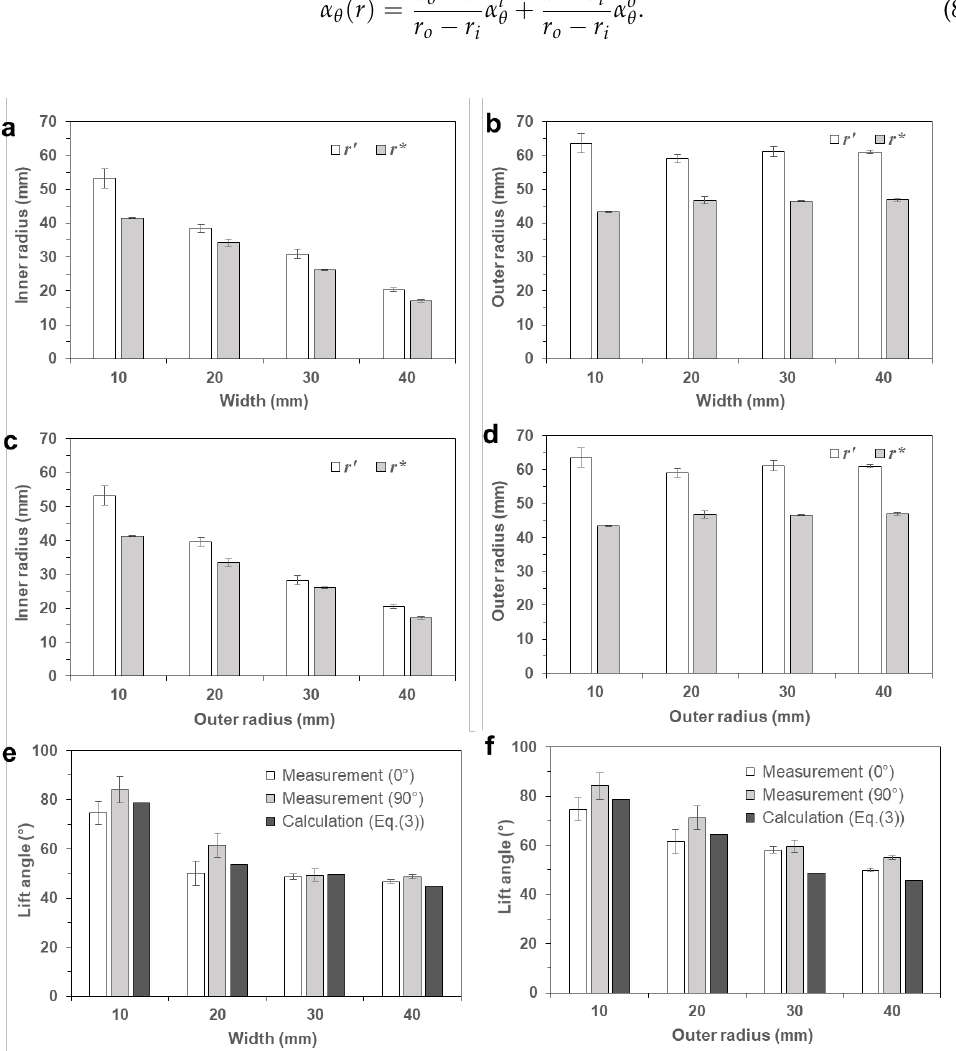
Figure 6. Comparison of deformed shapes of the full annuli: ( a ) deformed inner radii with various widths; ( b ) deformed outer radii with various widths; ( c ) deformed inner radii with various outer radii; ( d ) deformed outer radii with various outer radii; ( e ) lift angles with various widths; ( f ) lift angles with various outer radii.